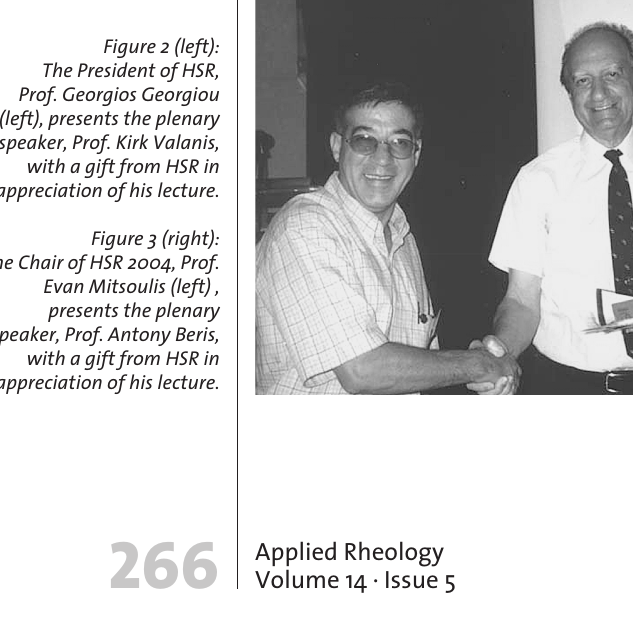
Figure 2 (left): The President of HSR,